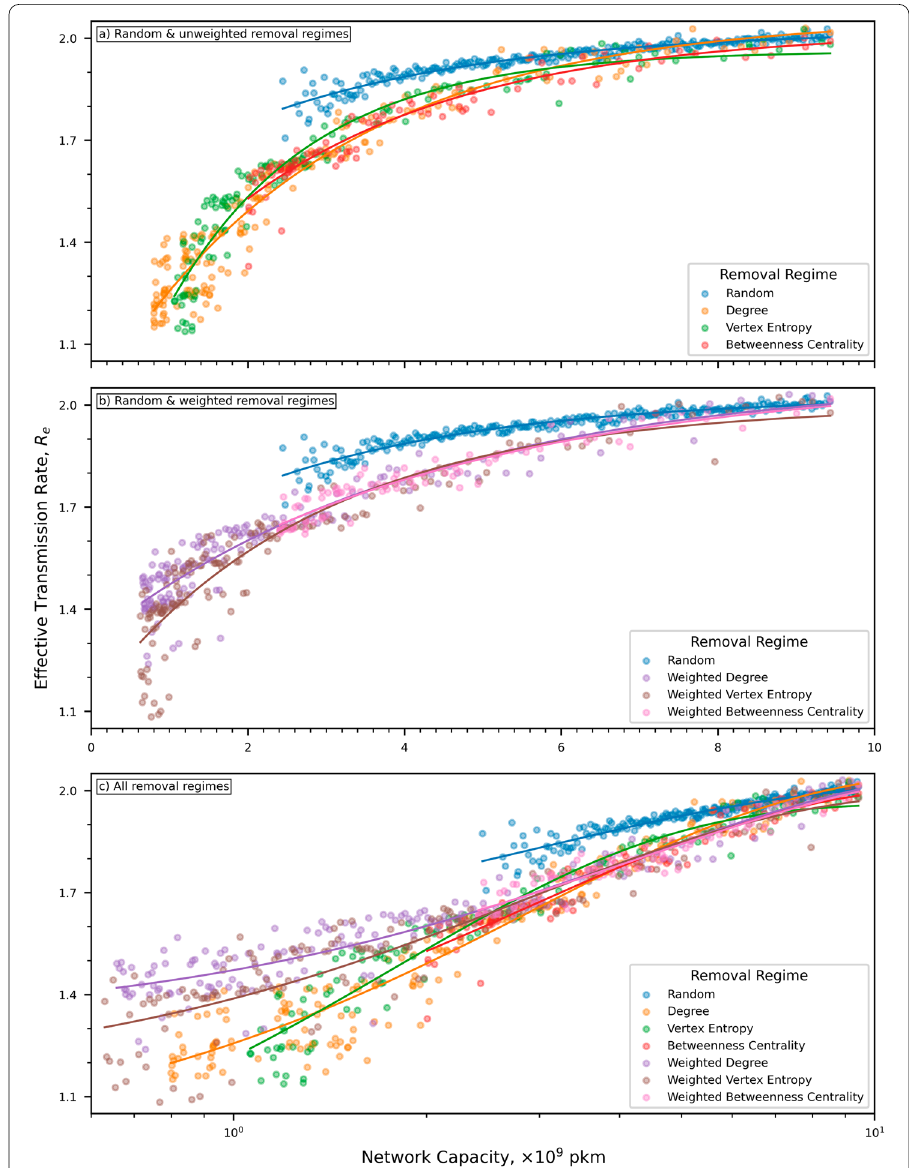
Fig. 6 The reduction in effective transmission rate as the capacity of the airline network reduces under random and targeted node removal. a Compares random removal with all unweighted regimes, b compares random removal with the weighted regimes, and c compares all regimes with capacity on log scale. Targeted node removal regimes retain a higher network capacity for a given transmission rate when compared with random node removal. Above a network capacity of 3.0 × 10 9 pkm the behavior of all targeted regimes behave similarly. Below 3.0 × 10 9 pkm the behaviors diverge with the unweighted regimes exhibiting a lower transmission rate for a given network